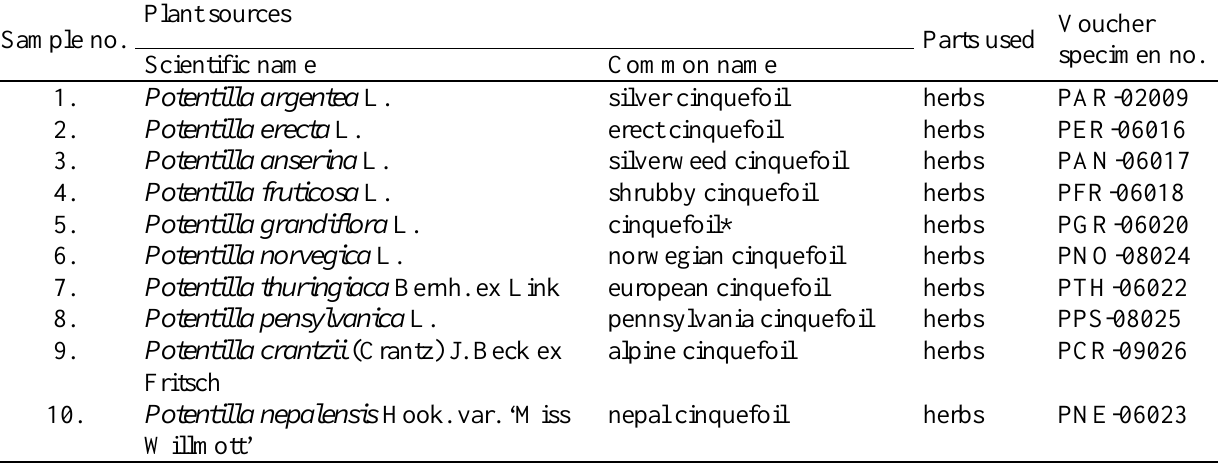
Table 1. Plant material from the selected Potentilla L. species. Sample